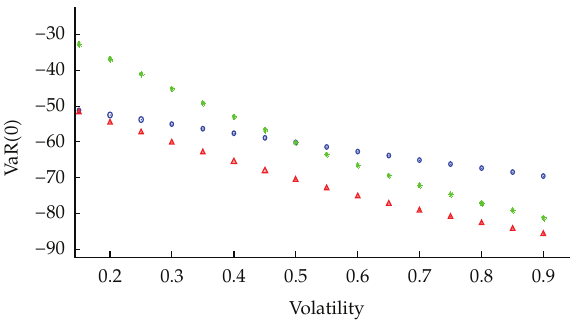
Figure 1: The impact of volatility on VaR. Note that the symbols “ ◦ ”, “ ∗ ”, and “ volatilities of domestic assets, foreign assets, and exchange rates on absolute VaRs,